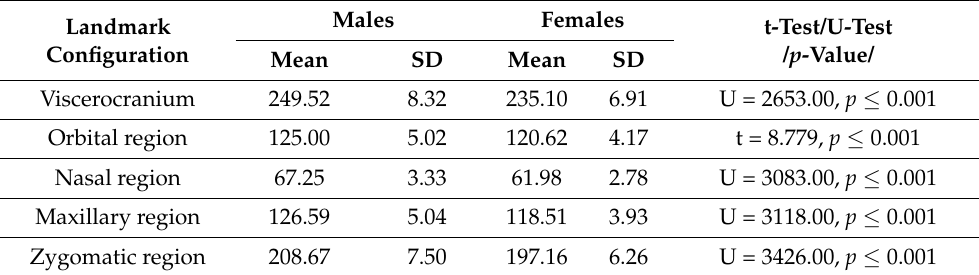
Table 2. Centroid size (in mm) of the configurations in male and female crania.